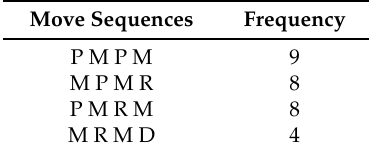
Table 7. Four move sequences that occur four or more times in 23 non-linear abstracts.